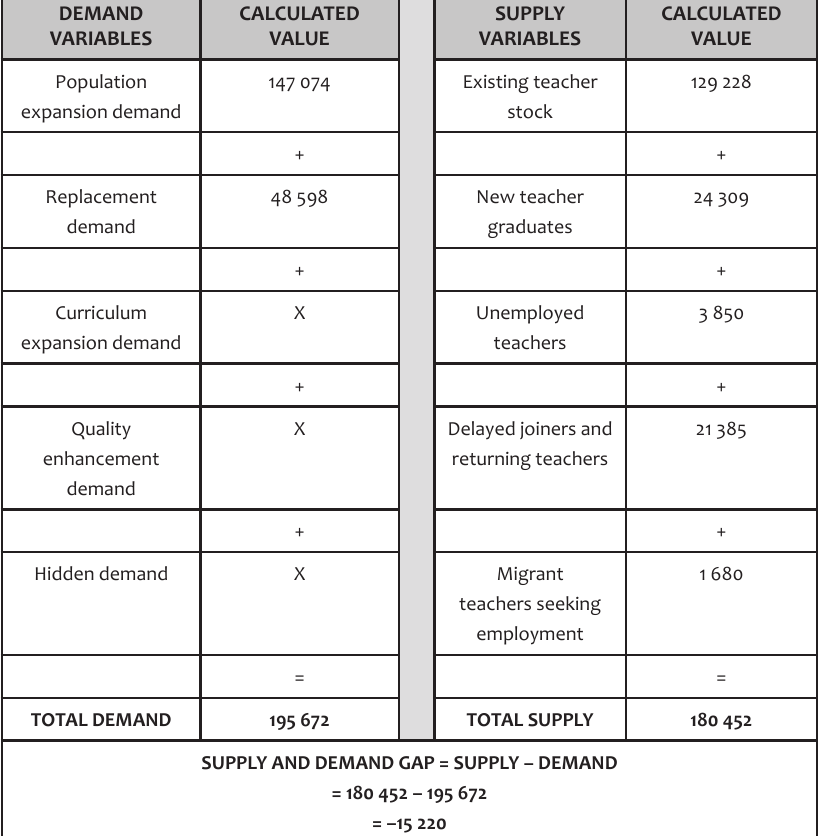
Table 5: Projected 2020 foundation phase teacher supply and demand gap DEMAND